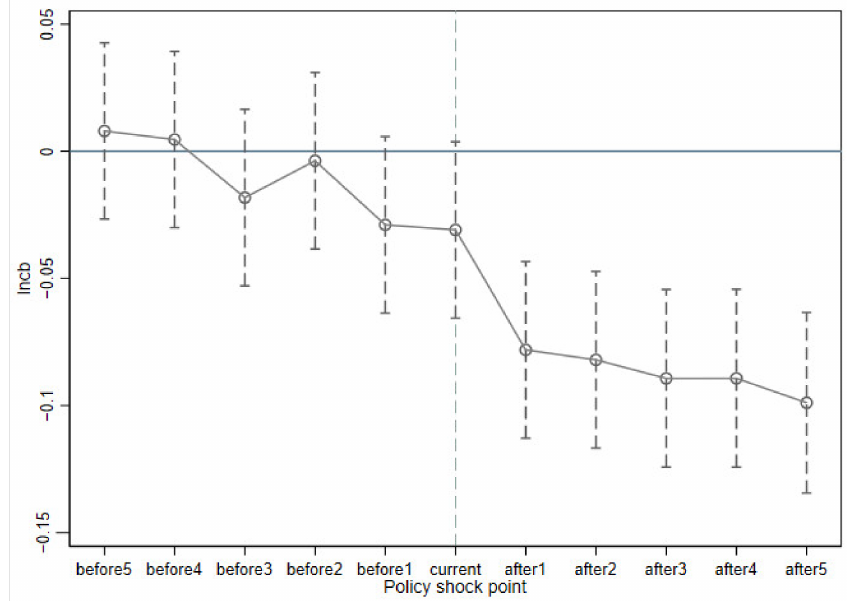
Figure 3. Event study